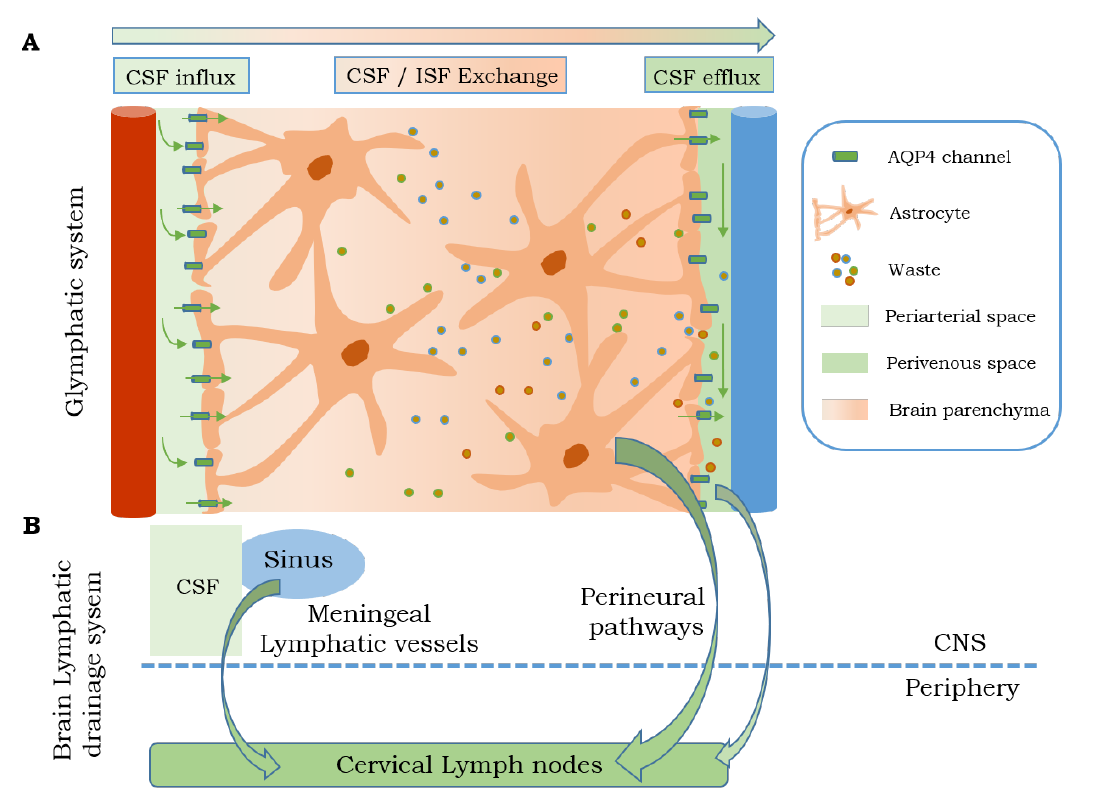
Figure 2. Brain lymphatic drainage system. ( A ) Glymphatic system clears solutes and waste of the brain parenchyma due to the influx of CSF from the periarterial space. Once the CSF is mixed with the ISF, they drain into the perivenous space. Part ( B ) shows a summary of the other brain drainage systems that transport the CSF through the meningeal lymphatic vessels and/or perineural pathways, such as olfactory nerve, to the cervical lymph nodes AQP: aquaporin; CNS: central nervous system; CSF: cerebrospinal fluid; ISF: interstitial fluid.